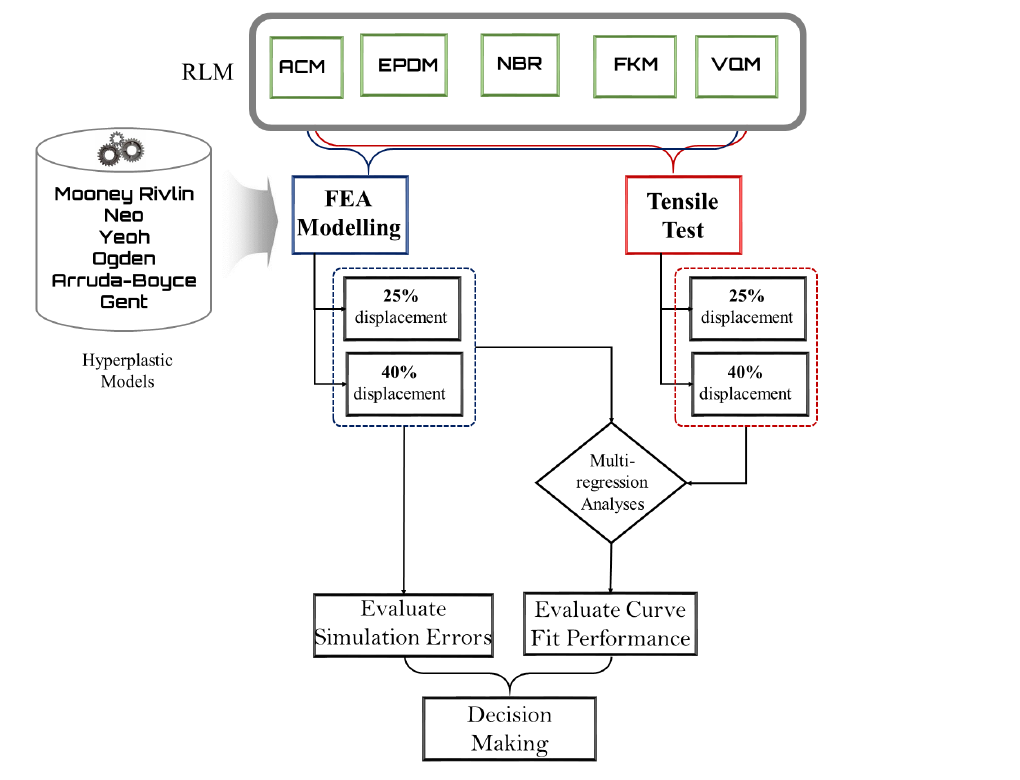
Figure 1. FEA-based Model/material Selection